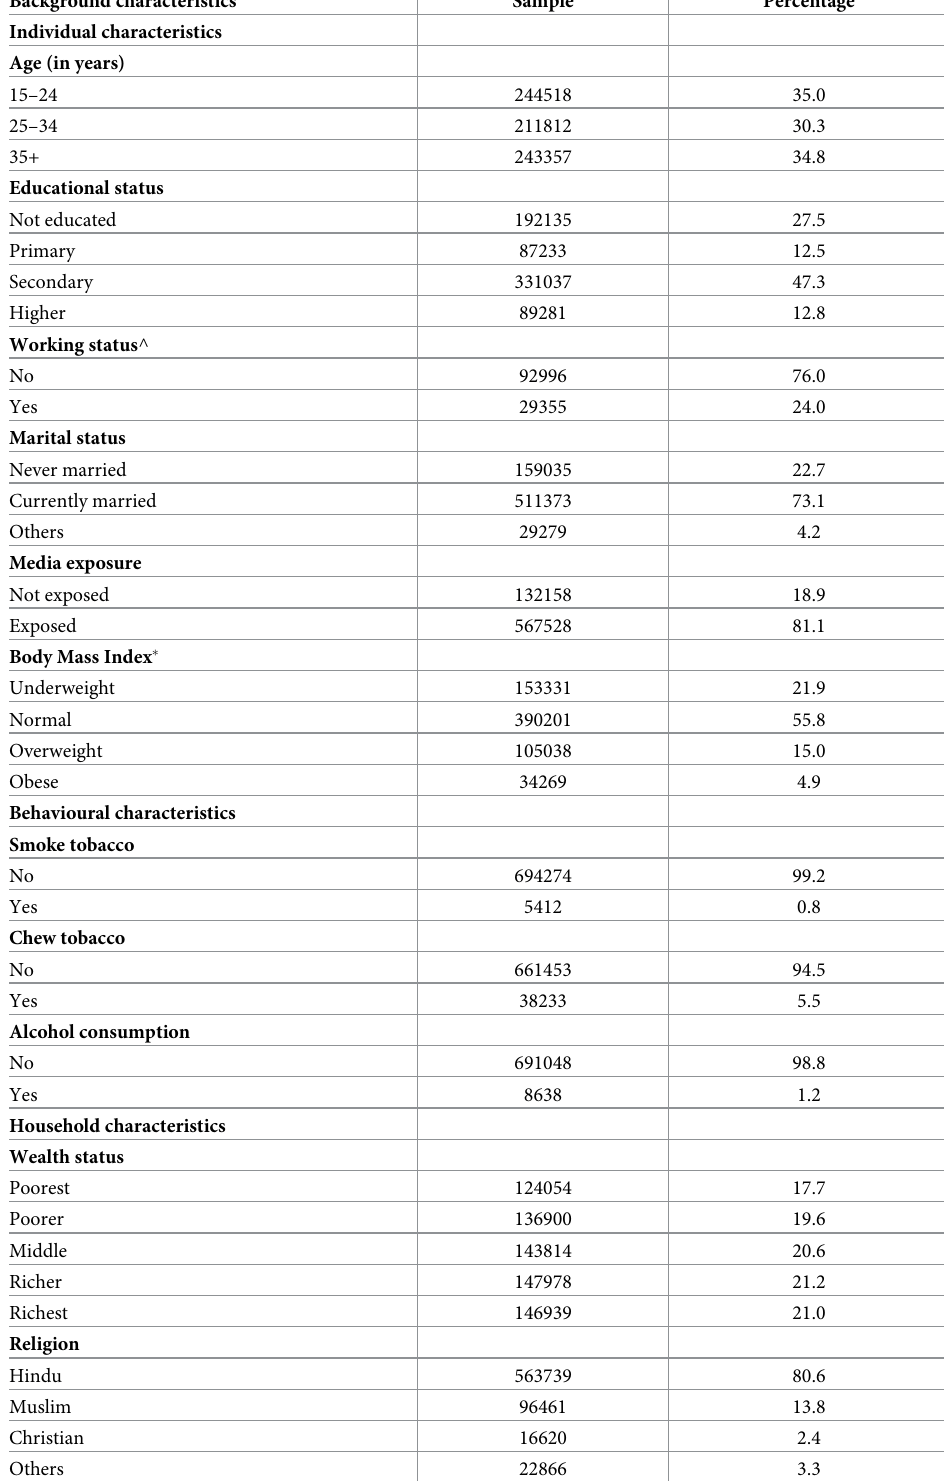
Table 1. Socio-economic profile of the women aged 15–49 years in India,